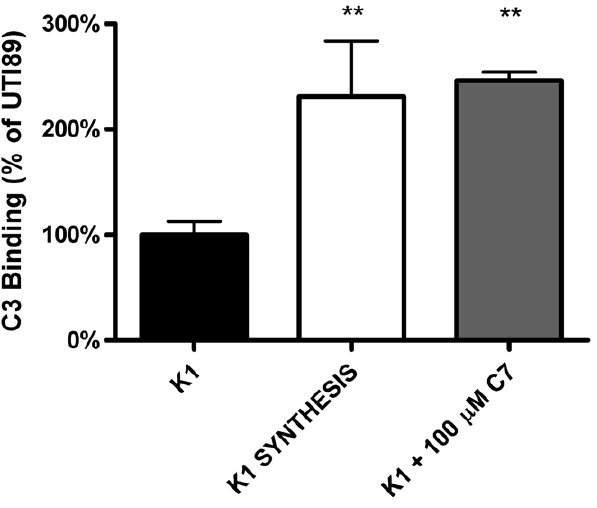
Figure 4. C7 increases C3 binding to UPEC K1. UTI89 was incubated with human serum and C3 binding was quantified by densitometry of immuno-dot blot. C7 treatment increases C3 binding to levels similar to an unencapsulated cell (K1 SYNTHESIS mutant; p=0.0054).